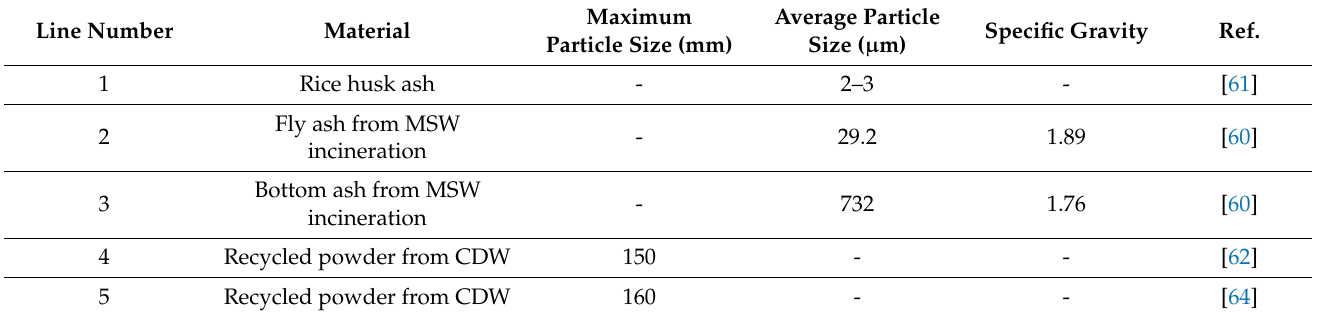
Table 4. Physical properties of different types of waste used in 3DPCC mixtures as unconventional SCM.